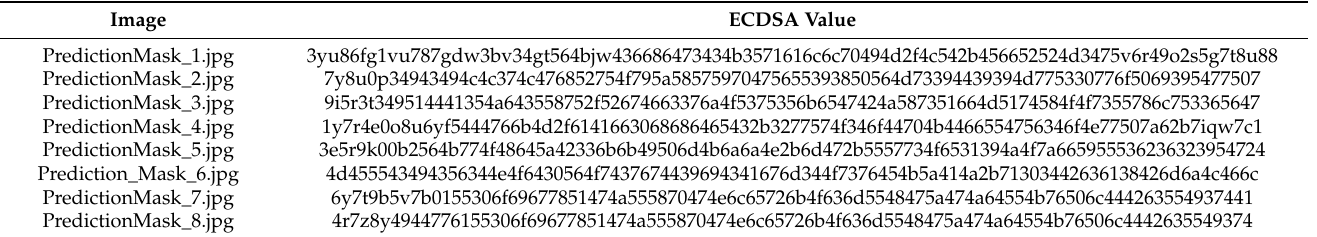
Table 2. Elliptic Curve digital signature values for corresponding images.